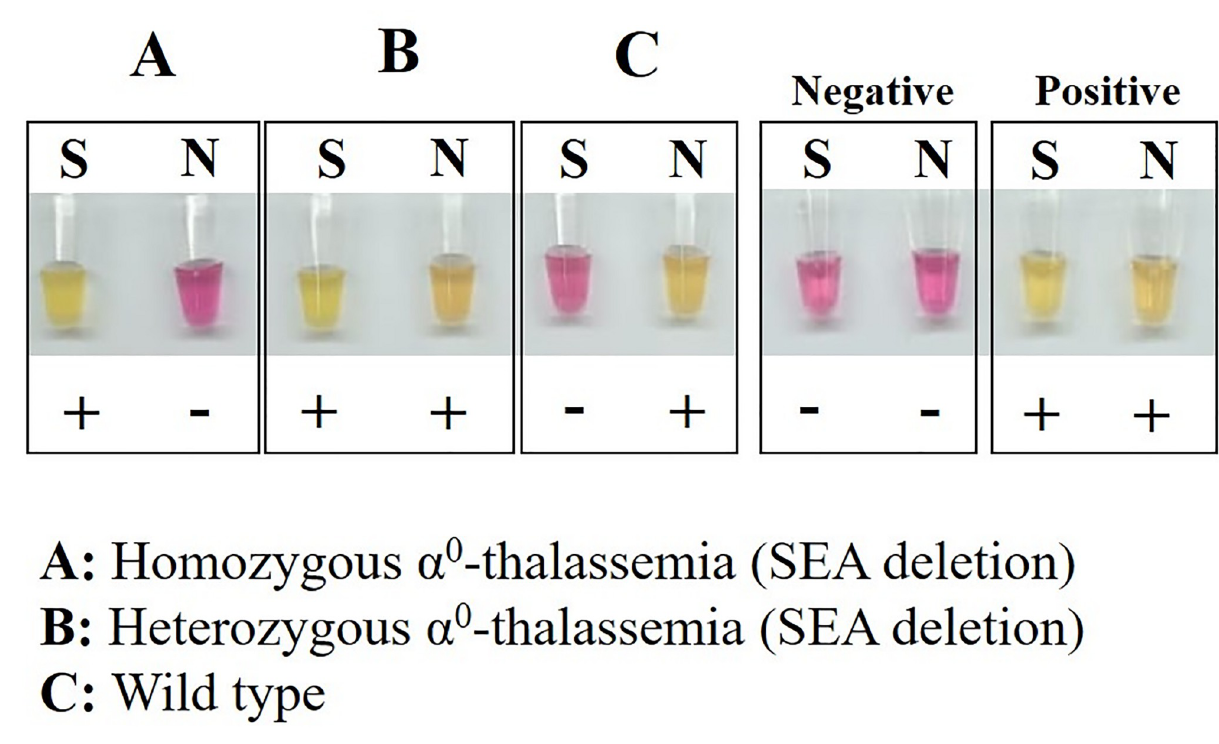
Fig 2. The possible genotypes of the fetus as examined using the LAMP colorimetric assays in prenatal diagnosis of Hb Bart’s hydrops fetalis syndrome (SEA deletion). A, B, and C represent homozygous α 0 -thalassemia, heterozygous α 0 -thalassemia, and normal subject, respectively. S and N indicate the LAMP colorimetric assays for α 0 -thalassemia (SEA deletion) and normal DNA sequence.